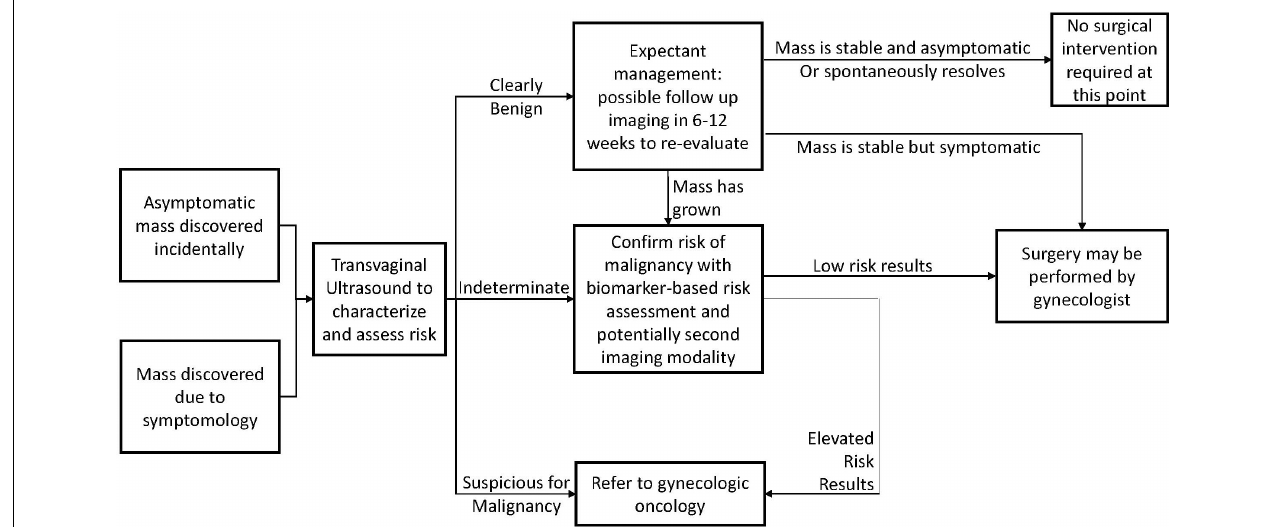
FIGURE 1 | A general care pathway for adnexal masses discovered in a family medicine